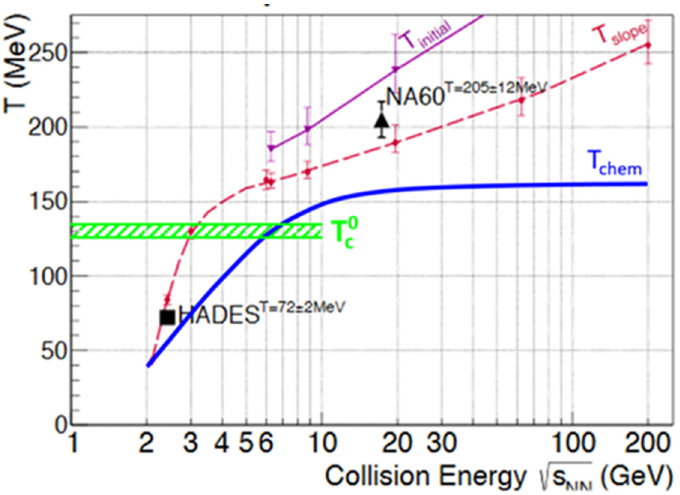
Figure 8. Fireball temperature as a function of heavy-ion collision energy [40]. The initial temperature T initial (purple line) and the average temperature T slope (magenta dashed line) above √ s NN = 6 GeV are calculated with a fireball model [42], whereas the low energy part of T slope was simulated by a coarse-graining method applied to a transport model [41]. The black data points are from HADES [43] and NA60 [44]. The blue line represents the chemical freeze-out temperatures [32], and the green area marks the maximum temperature of the critical endpoint from lattice QCD [26].